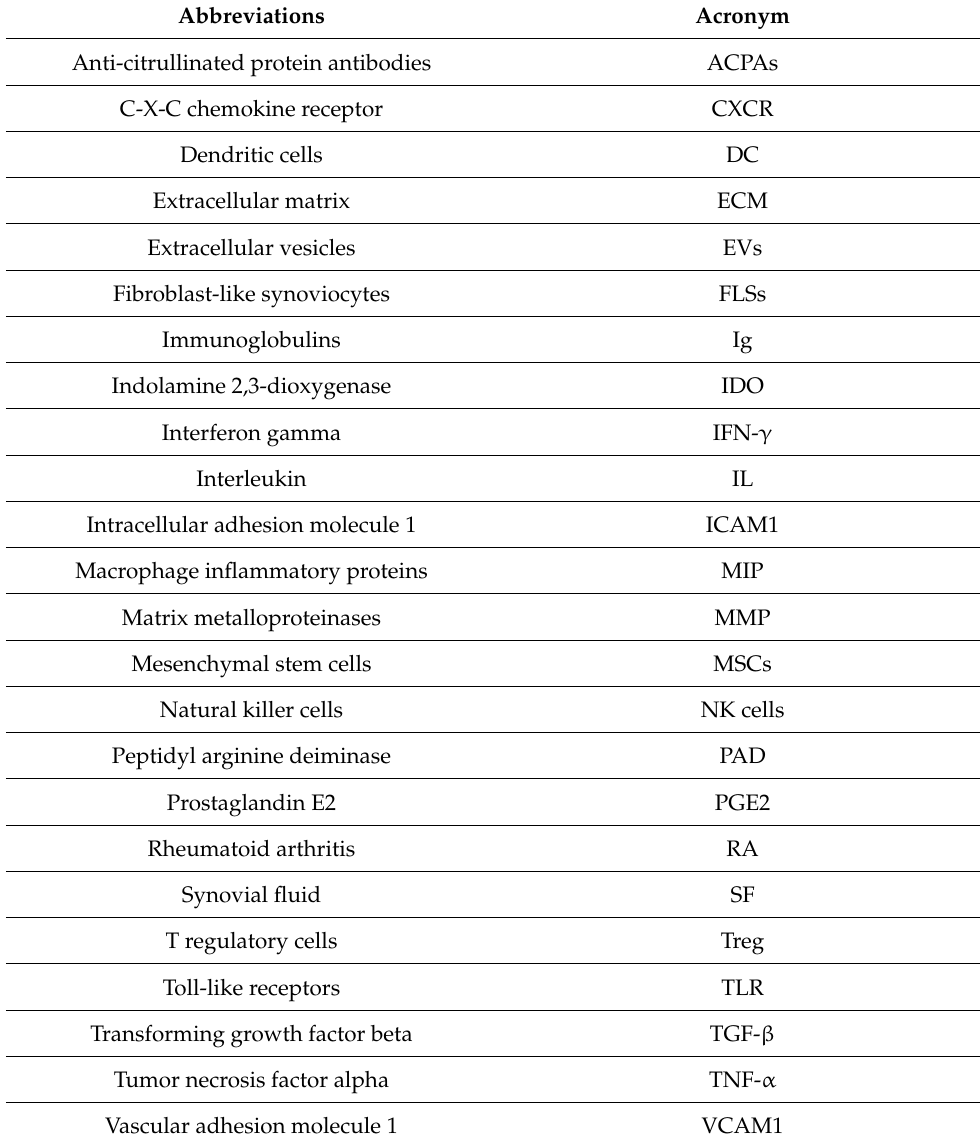
Table 1. Abbreviations often used in the